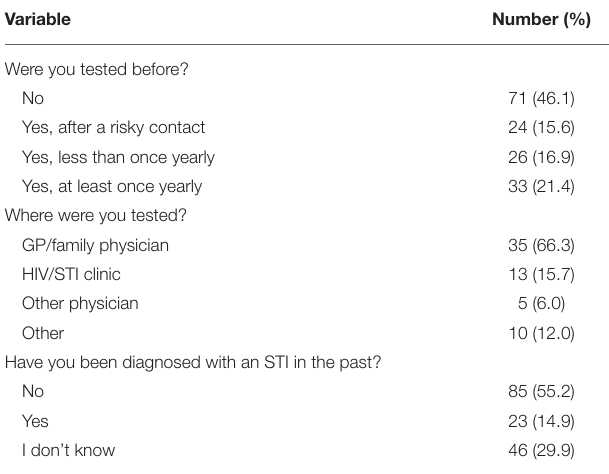
TABLE 2 | Testing history, and diagnosed STIs in the